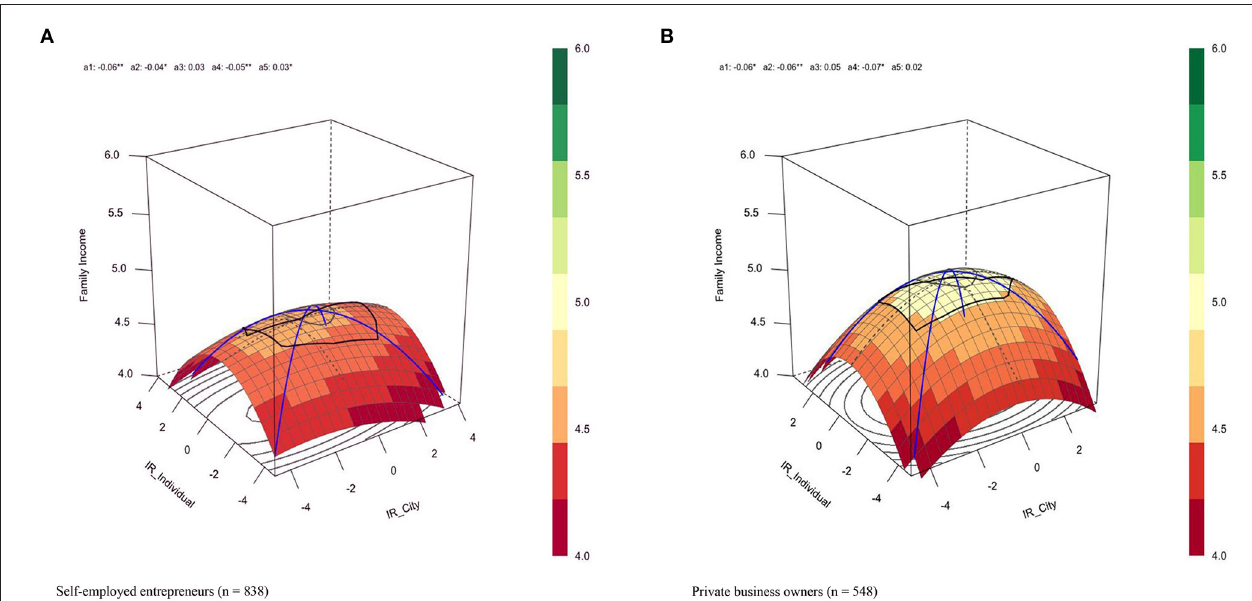
FIGURE 1 | Response surface plots for (A) self-employed entrepreneurs and (B) private business owners. E-IR, entrepreneur’s IR; R-IR, regional